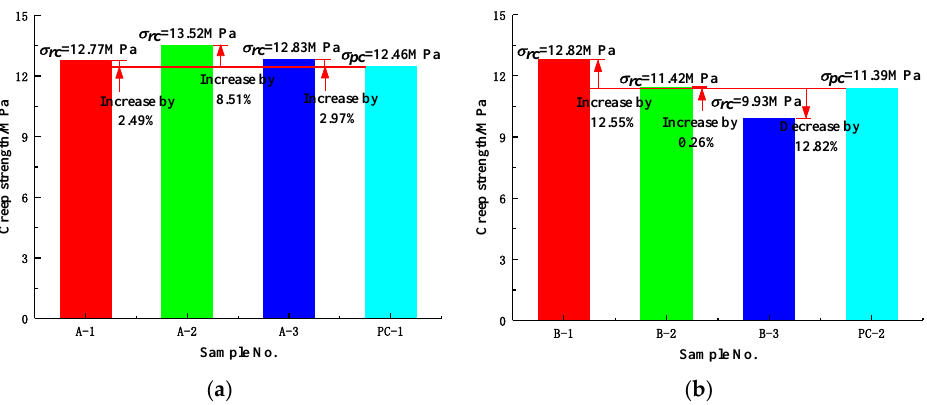
 for composite samples and pure coal samples: ( a ) Com-  and Figure 9. Comparisons of Figure 9. Comparisons of σ pc and σ rc for composite samples and pure coal samples: ( a ) Comparisons rc pc of σ pc and σ rc of Group A composite samples and PC-1 pure coal sample; ( b ) Comparisons of σ pc and  of Group A composite samples and PC-1 pure coal sample; ( b ) Com-  and parisons of rc pc σ rc of Group B composite samples and PC-2 pure coal  of Group B composite samples and PC-2 pure coal sample.  and parisons of rc pc